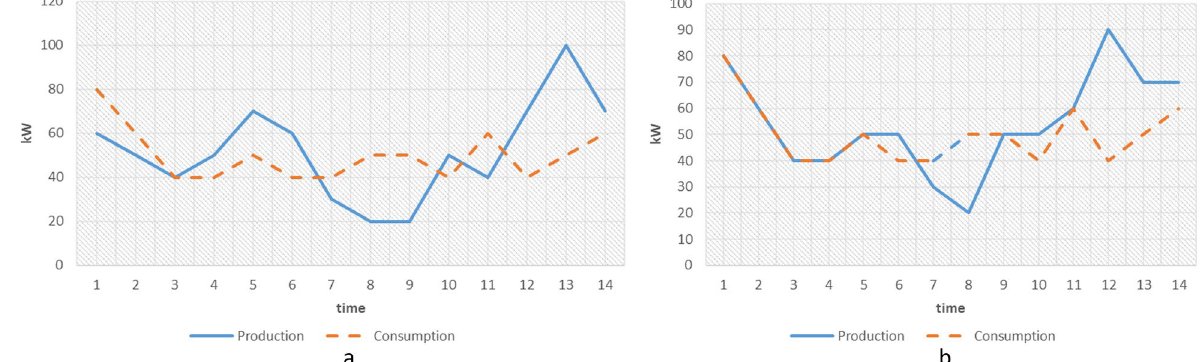
Fig. 6 Energy trading for DEP